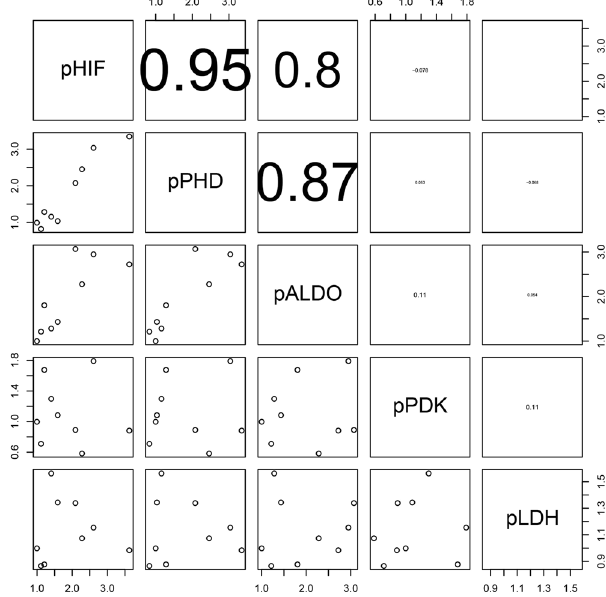
Figure 10. Correlation analysis of related gene expression in polyps.